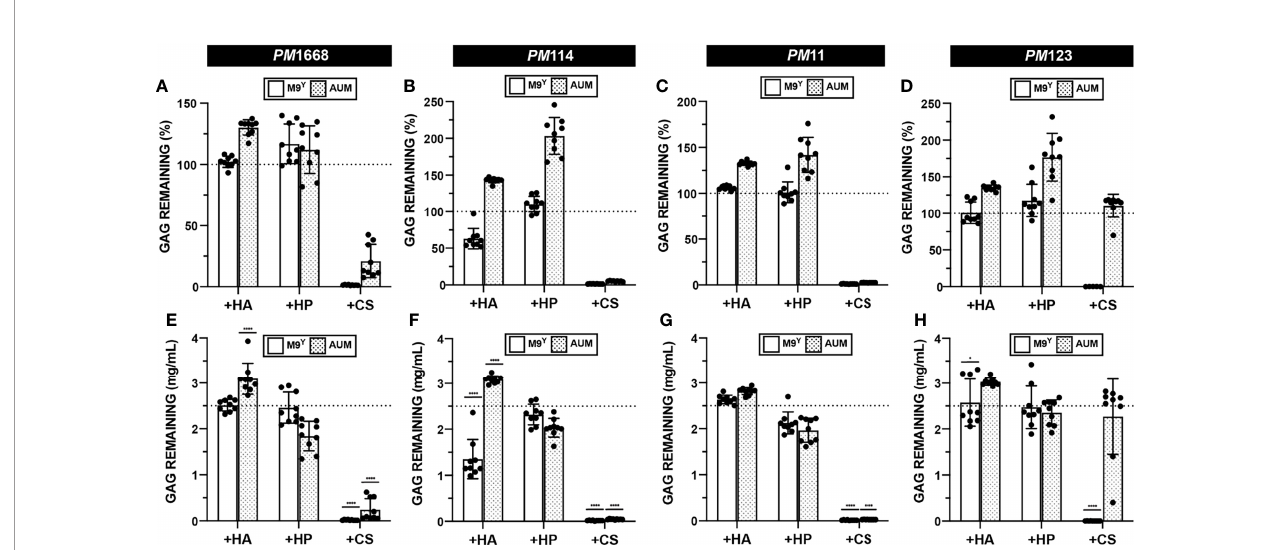
FIGURE 7 | Quanti fi cation of GAG degradation by P. mirabilis . HA, HP, and CS degradation assays were performed on four separate urinary P. mirabilis (PM) strains: (A, E) PM1668 (B, F) PM114 (C, G) PM11 (D, H) PM123 in either basal (M9 Y ) and AUM media. Semi-quantitative GAG percent remaining was calculated (A – D) . Absolute abundances of GAGS were interpolated from experimentally generated standard curves (E – H) . All points represent values across three biological replicates and three technical replicates and error bars represent standard deviation from the mean. An ordinary one-way ANOVA with Dunnett ’ s Multiple Comparisons Test was performed on absolute abundances to compare interpolated GAG concentrations with a 2.5mg/mL baseline GAG pre-incubation concentration. Statistically signi fi cant comparisons with effect sizes >1.25 fold above or below baseline are shown (*p < 0.05, ****p <